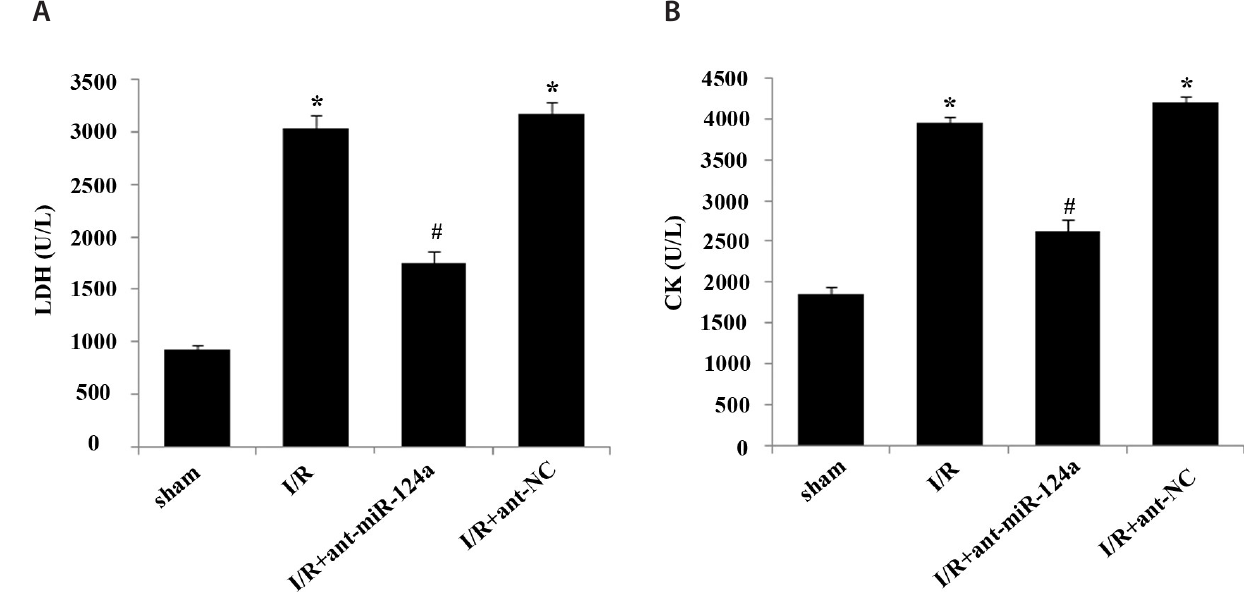
Fig. 2 - Effects of micro ribonucleic acid (miR)-124a on serum activities of lactate dehydrogenase (LDH) and creatine kinase (CK) in rats after ischemia reperfusion (I/R) injury. (A) Serum LDH activity in each group. (B) Serum CK activity in each group. Compared with sham group, *P<0.05; compared with I/R group, #P<0.05. ant=antagomir; NC=normal